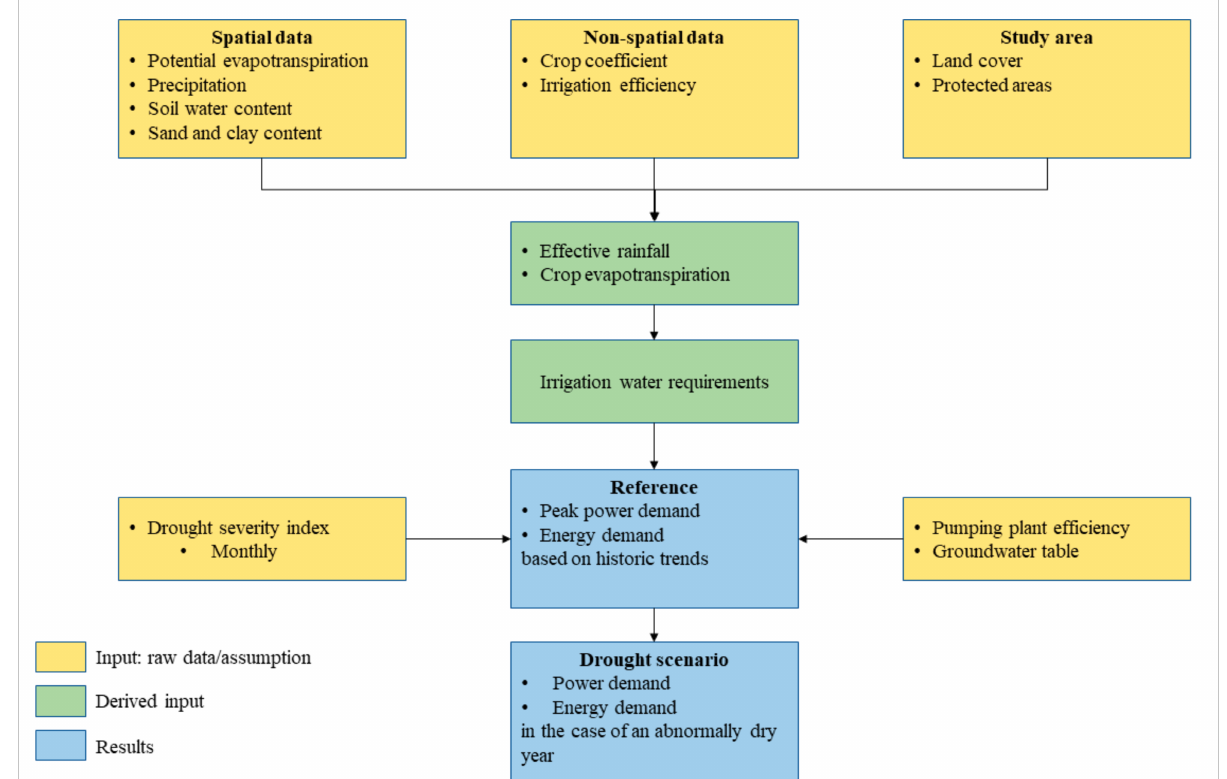
Figure 1. Methodological flow